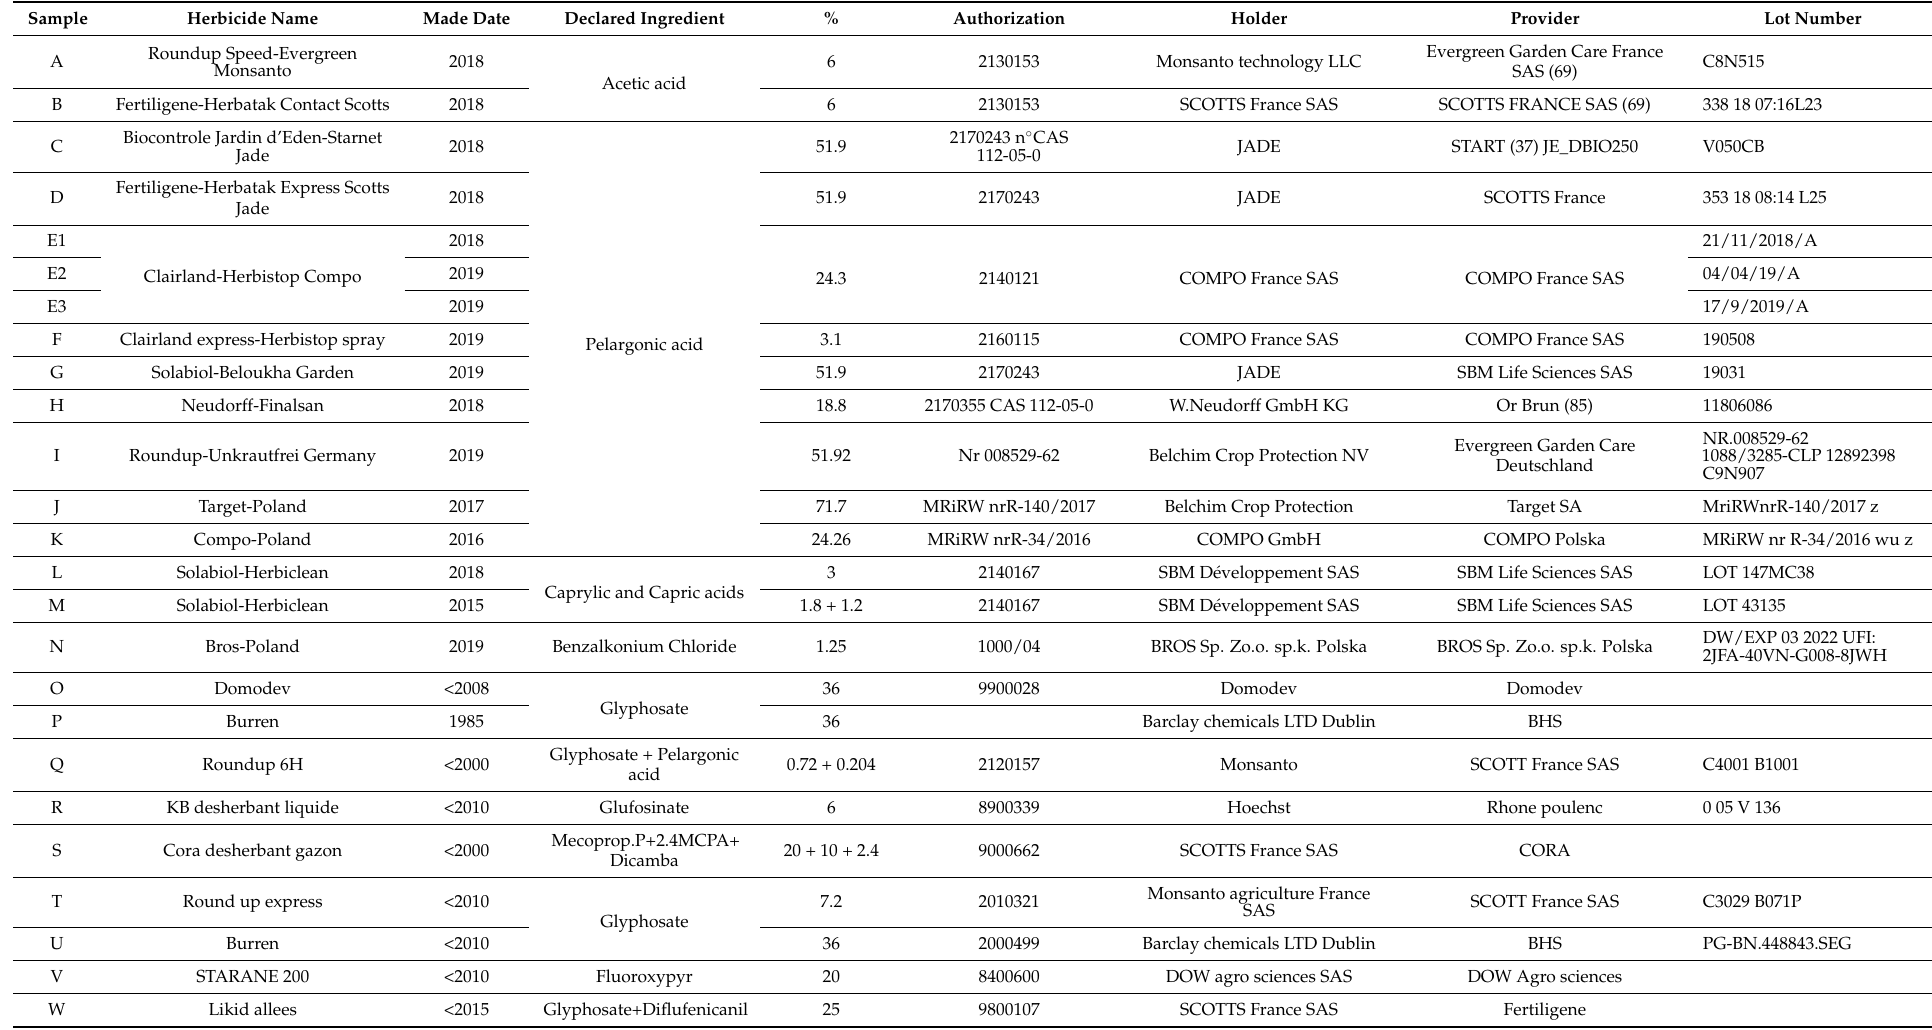
Table 2. Samples of herbicides used to measure PAHs in this study and dates of